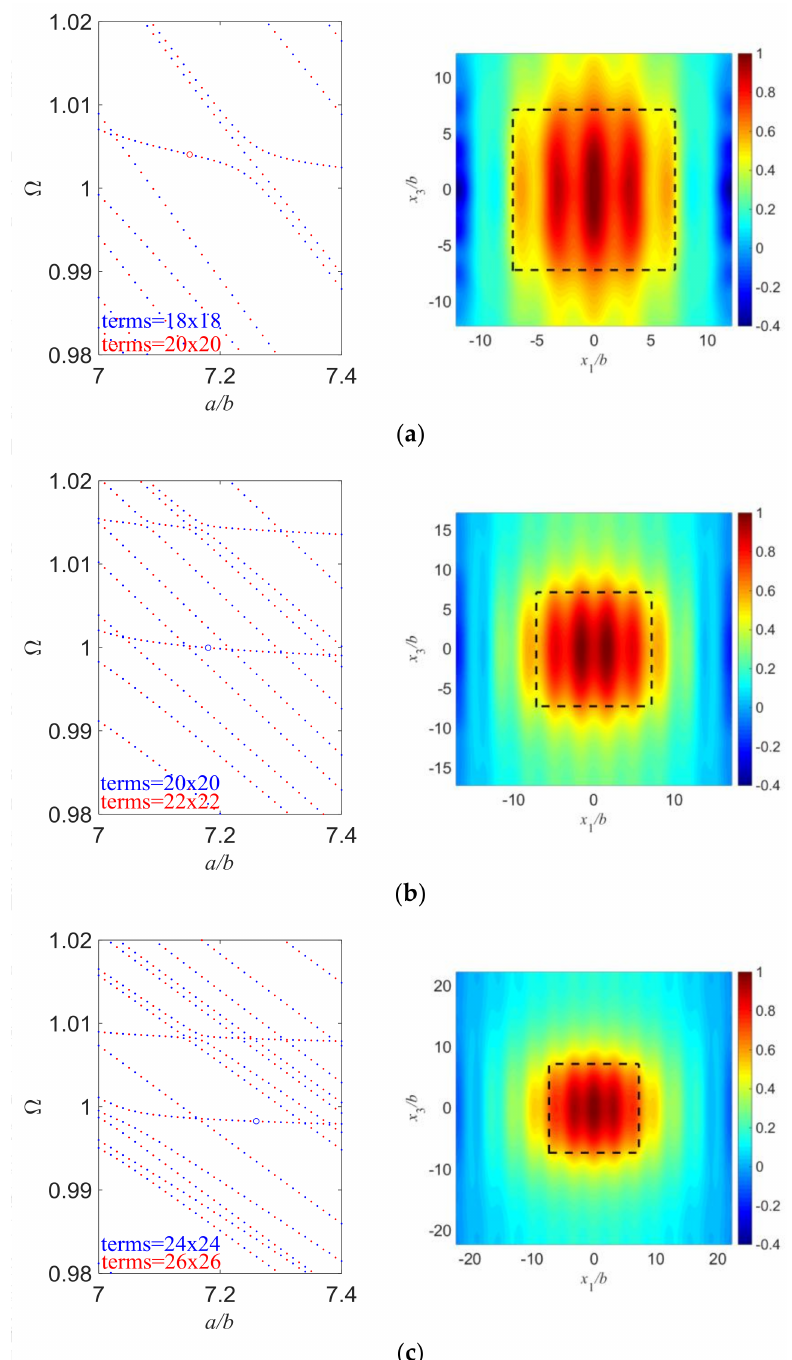
Figure 4. Essential TS modes with different d / b . ( a ) a / b = 7.15, d / b = 5, R = 0.01, Ω = 1.00404503; ( b ) a / b = 7.18, d / b = 10, R = 0.01, Ω = 0.99995715; ( c ) a / b = 7.26, d / b = 15, R = 0.01, Ω =